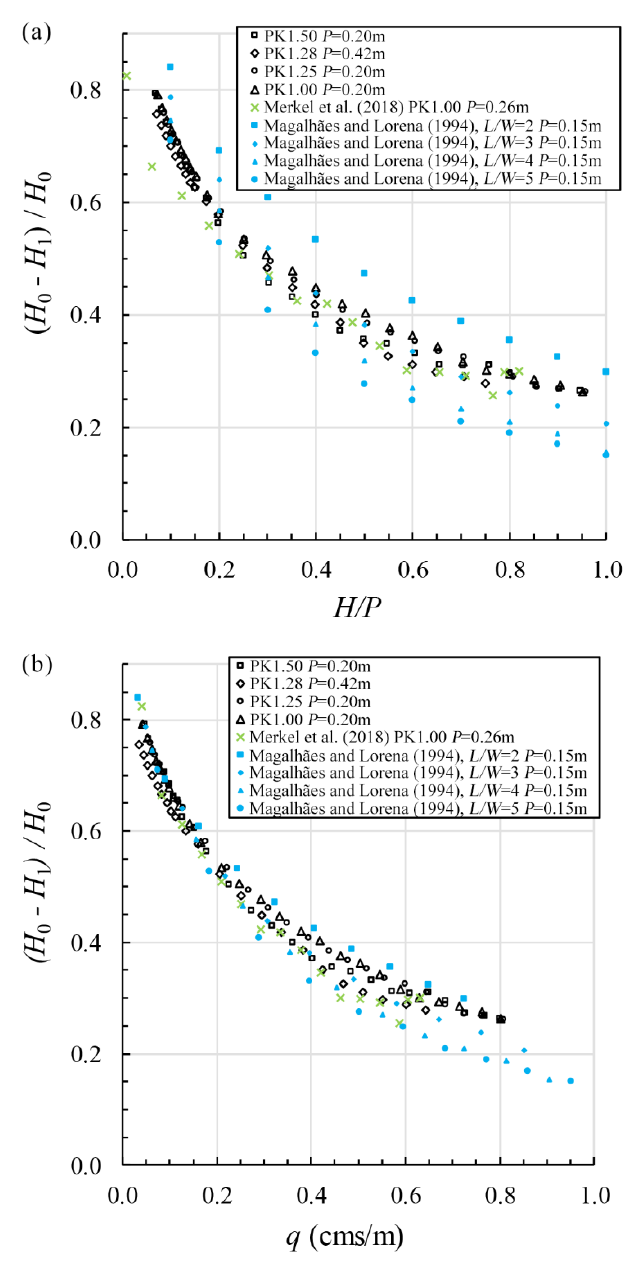
Figure 7. Relative energy dissipation [( H 0 − H 1 ) / H 0 ] with respect to ( a ) the head water ratio ( H / P ) and ( b ) unit discharge ( q ) for Type A PK weirs.